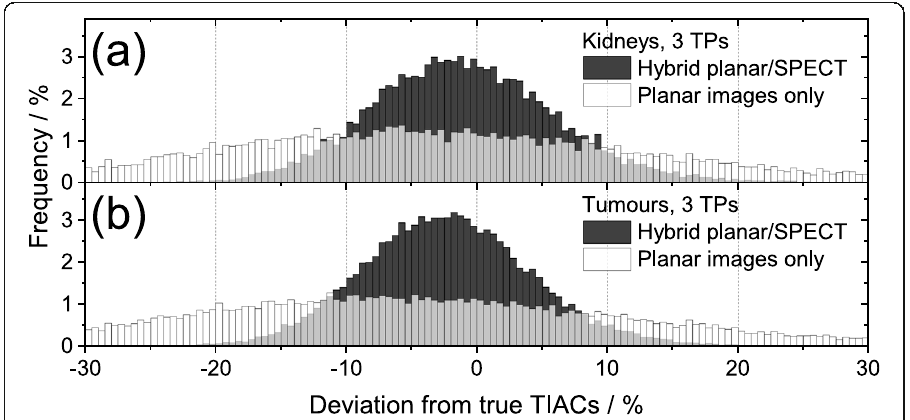
only are presented in Fig. 1. The broad frequency distribution of the simulated kidney TIACs based on the planar images e.g. led to about 25% of the TIACs deviating more than 20% from the ground truth. This percentage was reduced below 1% by using the hybrid planar/SPECT method instead. Fig. 2. One single SPECT/CT measurement at 52 h resulted in a high number of underesti- mations of the tumour TIACs (Fig. 2a). A more appropriate TP regarding only tumour dos- imetry was determined to be 72 h leading to the kidney and tumour RMSE values of 11 % (mean: − 6.1 ± 9.1%) and 12% (mean: − 7.8 ± 8.8%), respectively. Using two TPs led to a